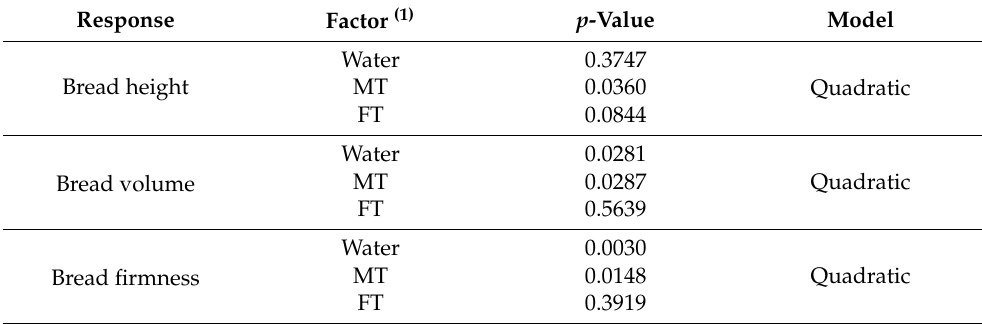
Table 5. Fitted model and significant factor identified based on p -values for the three representative quality characteristics of bread prepared with flour–bran blend at 30%